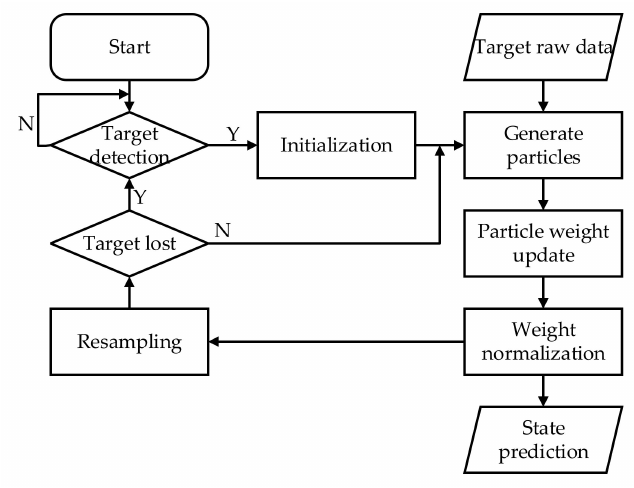
Figure 7. Particle filter (PF)